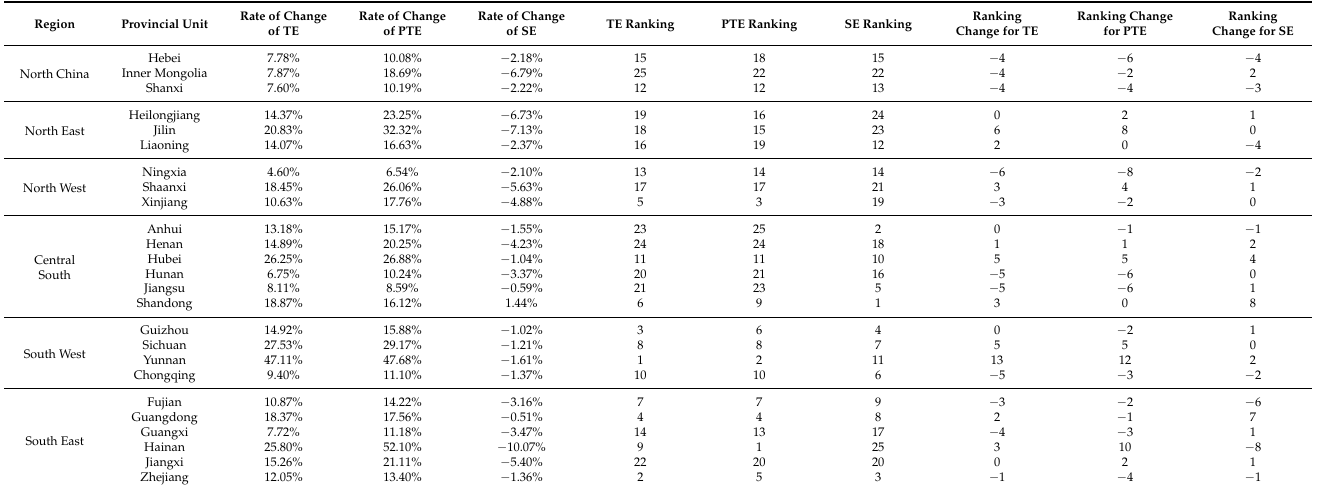
Table 5. Carbon sequestration output efficiency change rate, ranking, and ranking change of state- owned forest farms in China’s provinces from Stage 1 to Stage